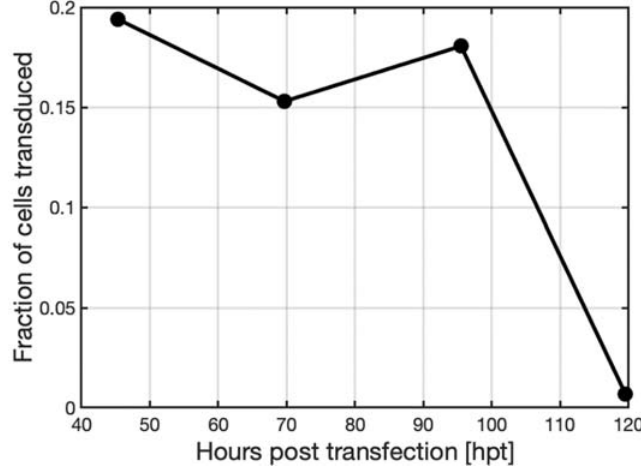
Figure 8. Transduction assay results of CHO cells using supernatant samples harvested at various time points from HEK293T cells immobilized on Cytodex 3 microcarriers after transfection at a final DNA concentration of 11.44 µg DNA mL − 1 in a 150 mL DASBox bioreactor operated in perfusion with a cell density at the time of transfection of 1.5 × 10 6 cells mL − 1 ; results indicated a stable AAV titer until day 4 followed by a decrease due to an increase of the perfusion rate.